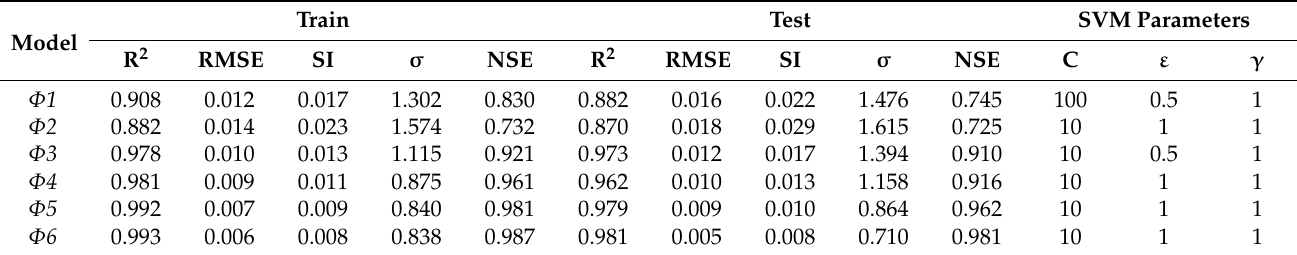
Table 9. Evaluation of hybrid models in WP